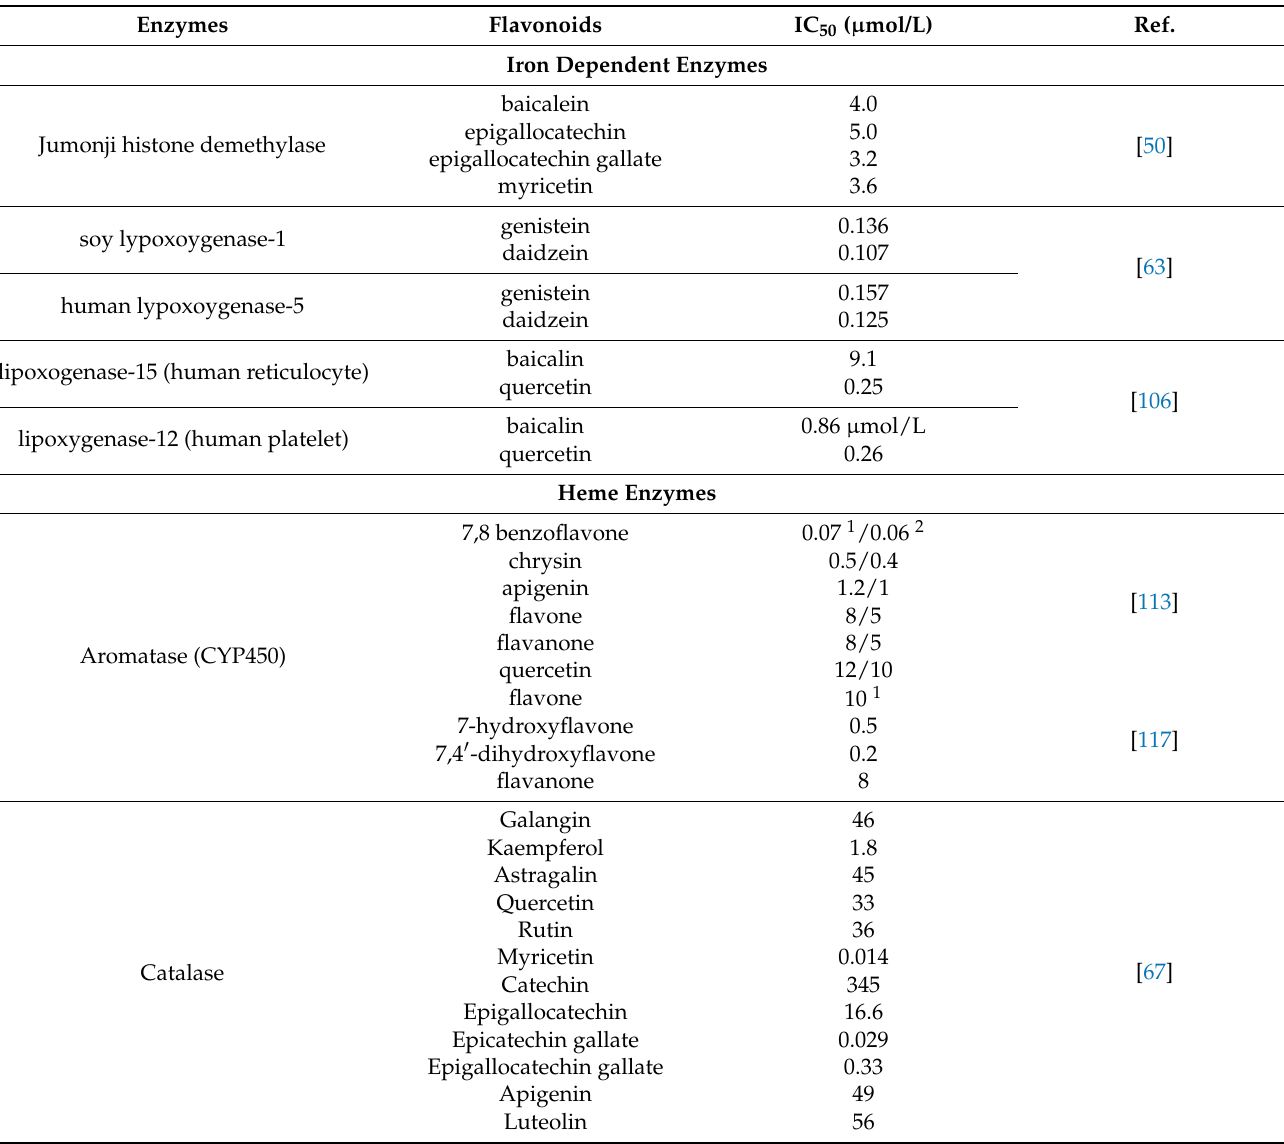
Table 2. Flavonoid inhibition activity on the iron depended and heme